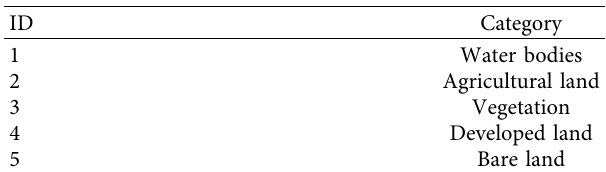
Figure 2: Urban lakes extracted from Landsat images in 1991 and 2002. Table 1: Land use